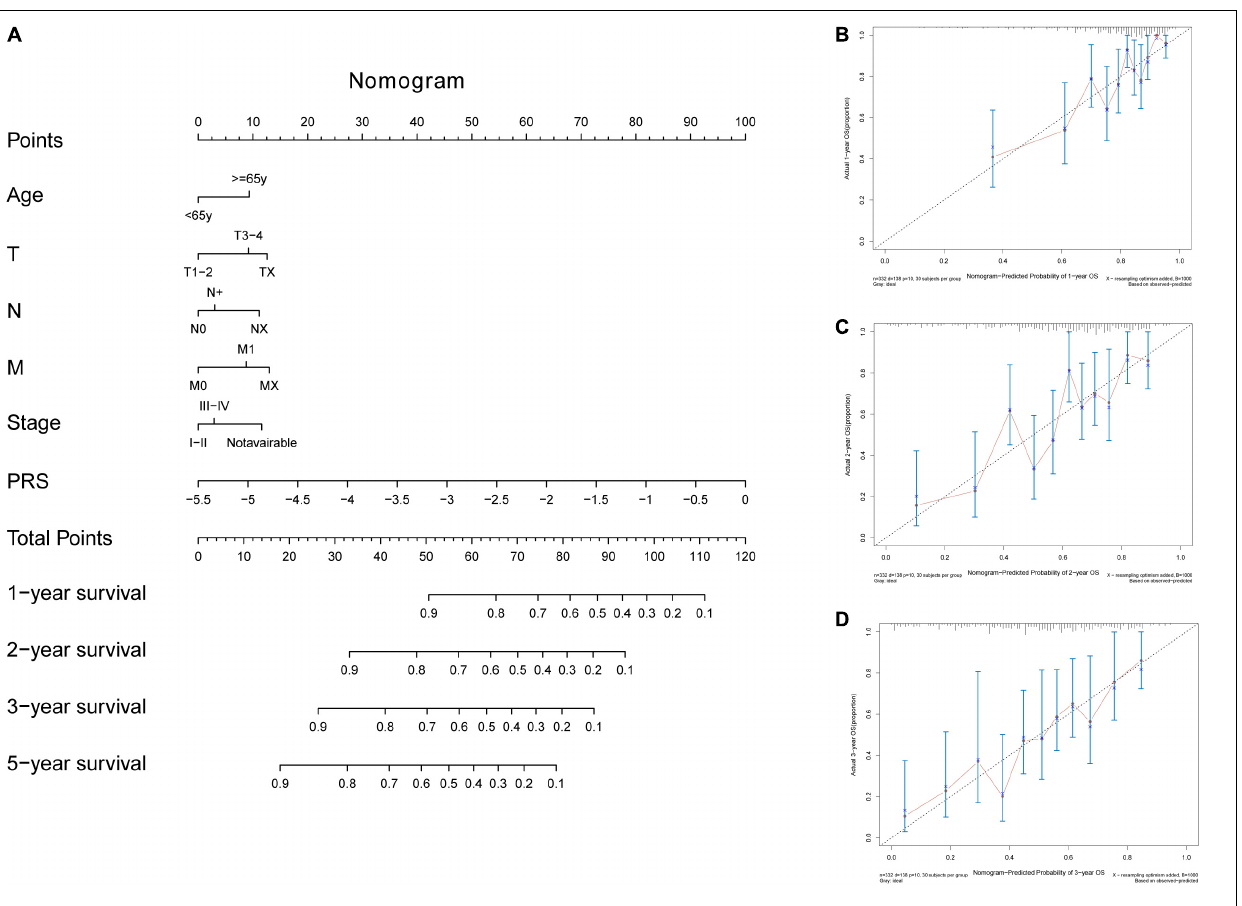
FIGURE 6 | The nomogram tool for predicting survival rate in the TCGA-STAD dataset. (A) The nomogram tool. (B) Calibration curves for 1-year, (C) 2-year, and (D) 3-year survival rates with the nomogram tool.